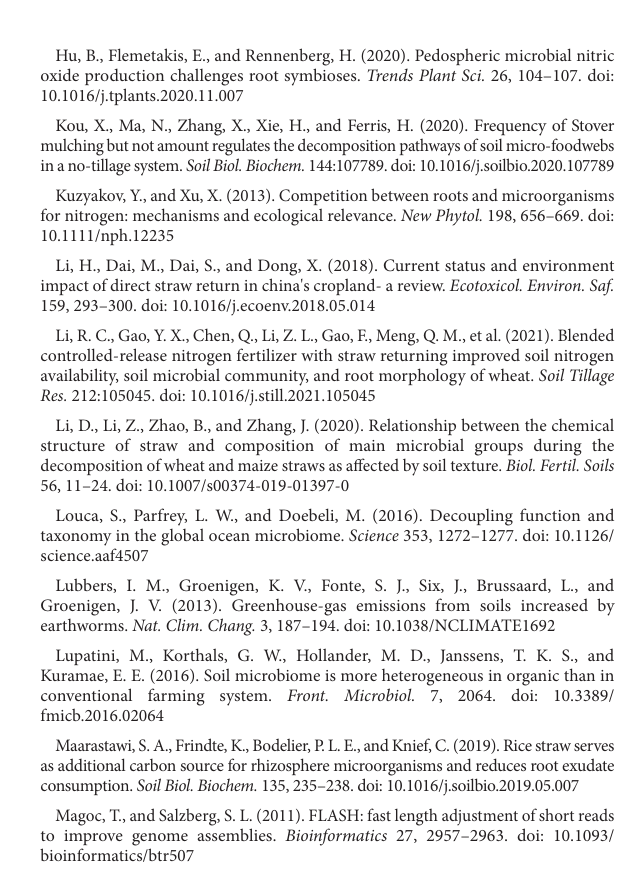
SUPPLEMENTARY TABLE S1 The bacterial (Sheet1) and fungal (Sheet2) functional guilds in the